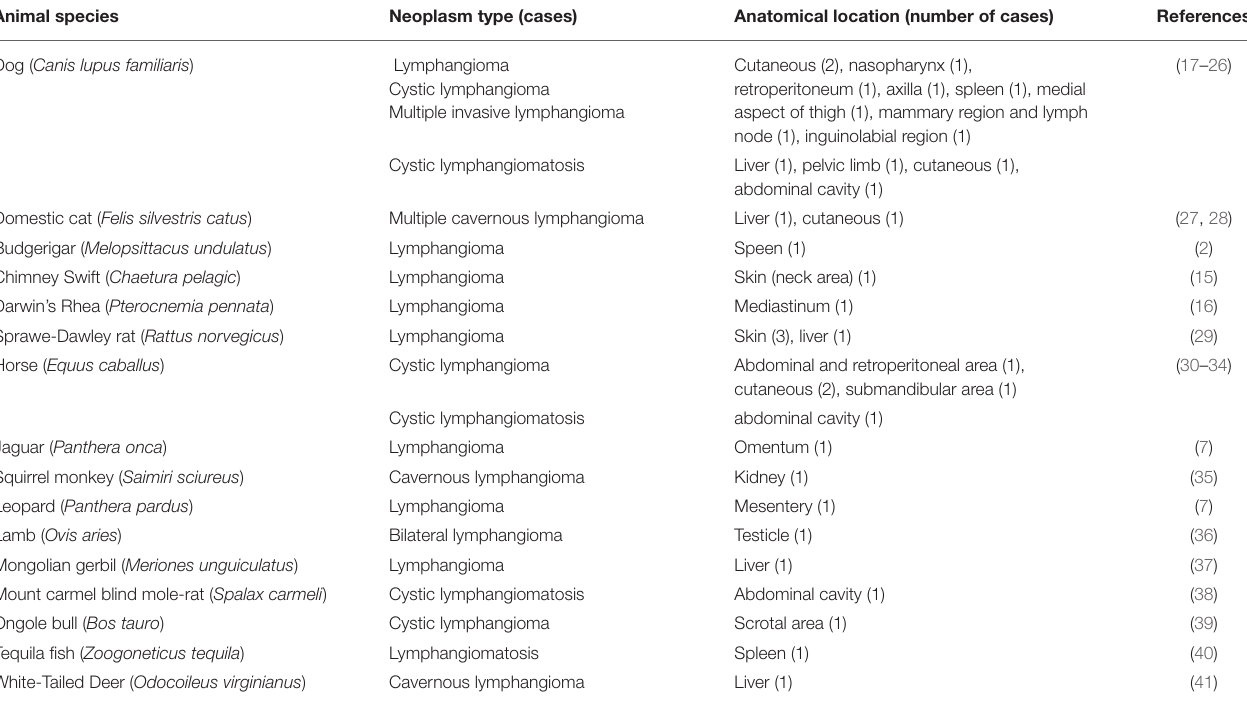
TABLE 1 | Number of cases of benign tumors of lymphatic vessels (lymphangiomas and lymphangiomatosis) in the different animal species, other than humans, reported in the literature. Animal